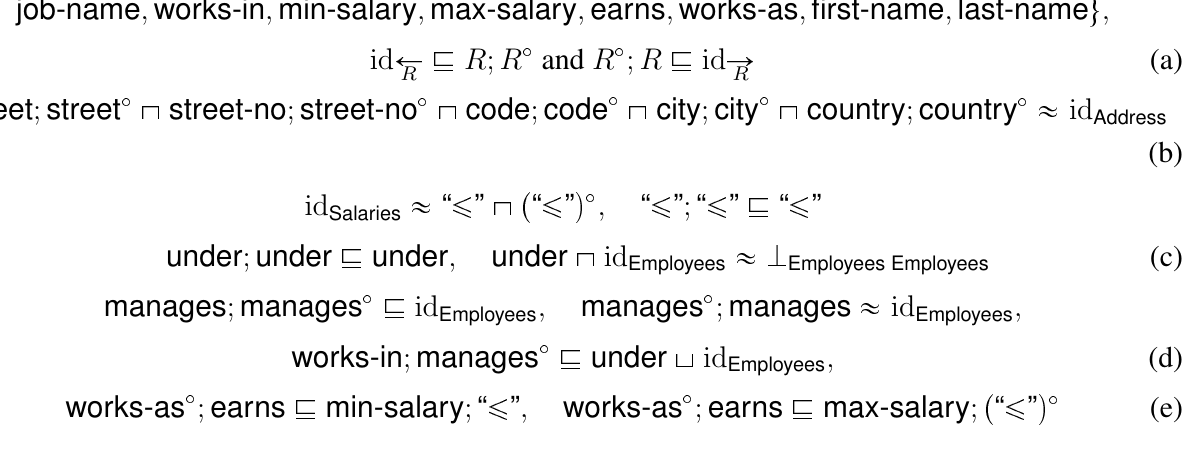
Figure 2. Equations specifying the properties of relations from Figure